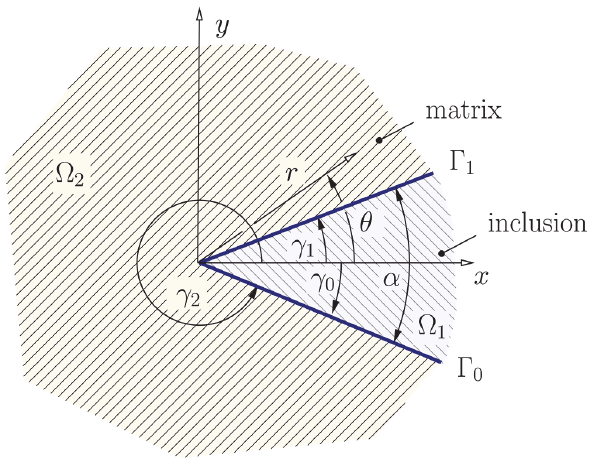
Figure 1: Sharp material inclusion